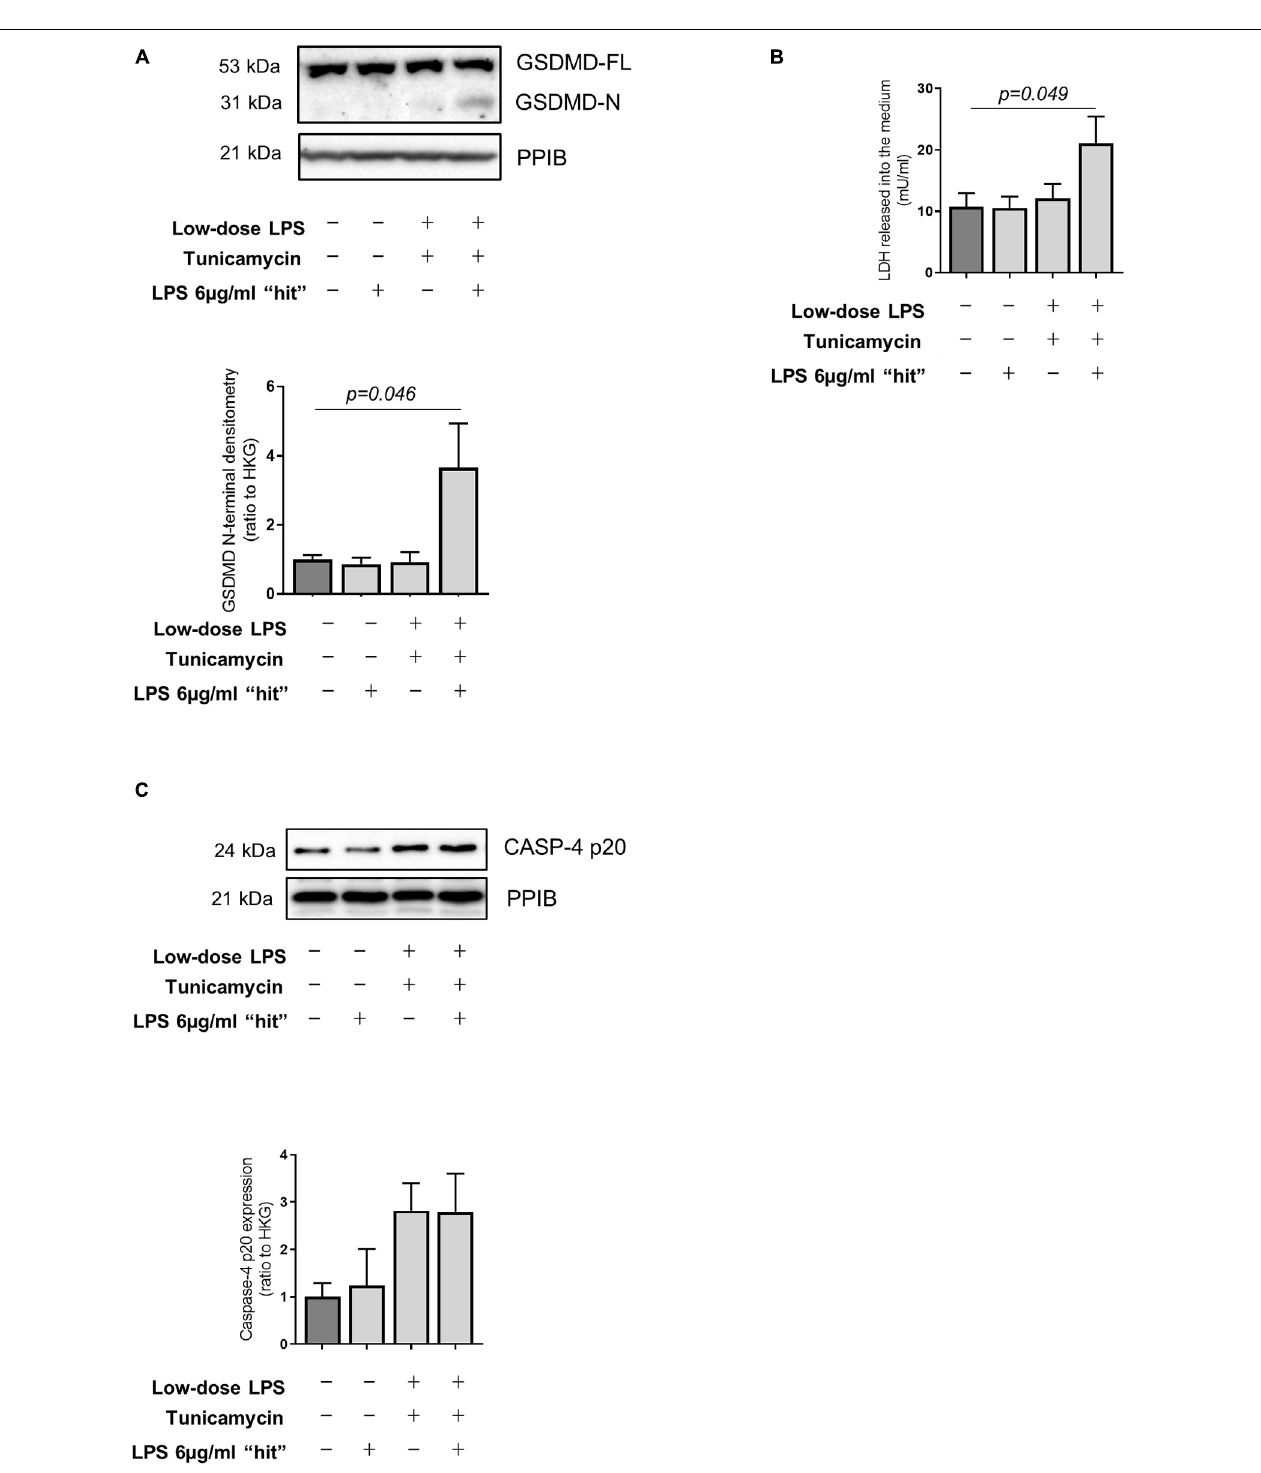
FIGURE 5 | LPS-dependent pyroptosis in hepatocytes and sensitization by ER stress. (A) Primary human hepatocytes treated for 24 h with very low-dose LPS (100 ng/ml) and the ER-stress inducer tunicamycin (1 µ M) prior to subsequent LPS ‘hit’ (6 µ g/ml) show increased GSDMD cleavage compared to control (one-way ANOVA with Tukey post hoc test, p = 0.046, n = 3 experiments/group). (B) Susceptibility to induced pyroptosis was confirmed by increased release of LDH upon LPS “hit,” by hepatocytes treated with low-dose LPS (100 ng/ml) and tunicamycin (1 µ M) (one-way ANOVA with Tukey post hoc test, p = 0.049, n = 3 experiments/group). (C) Primary human hepatocytes showed a trend toward increased active Caspase-4 upon tunicamycin treatment, as measured by the abundance of the p20 fragment.